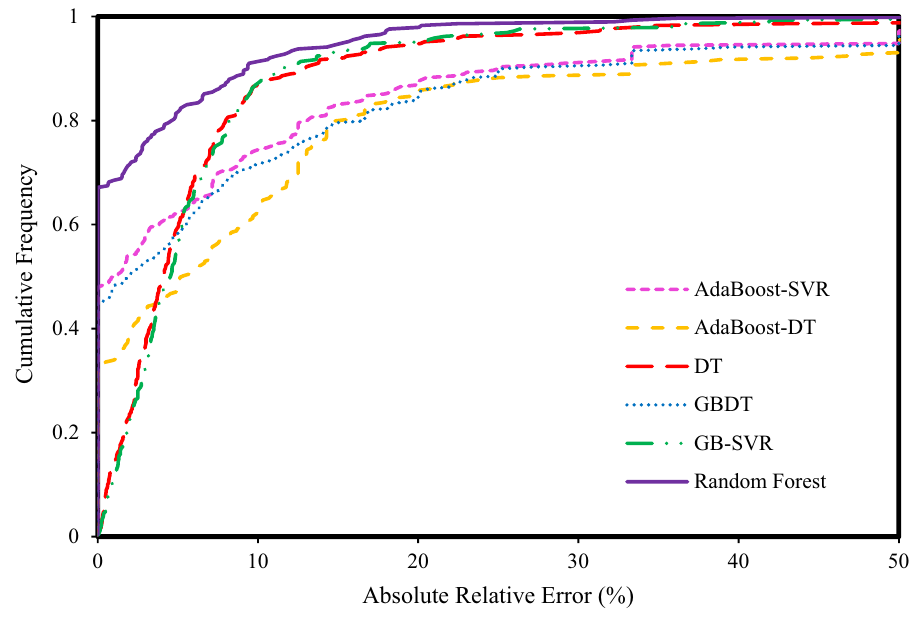
Figure 6. The cumulative frequency plot for the developed predictive